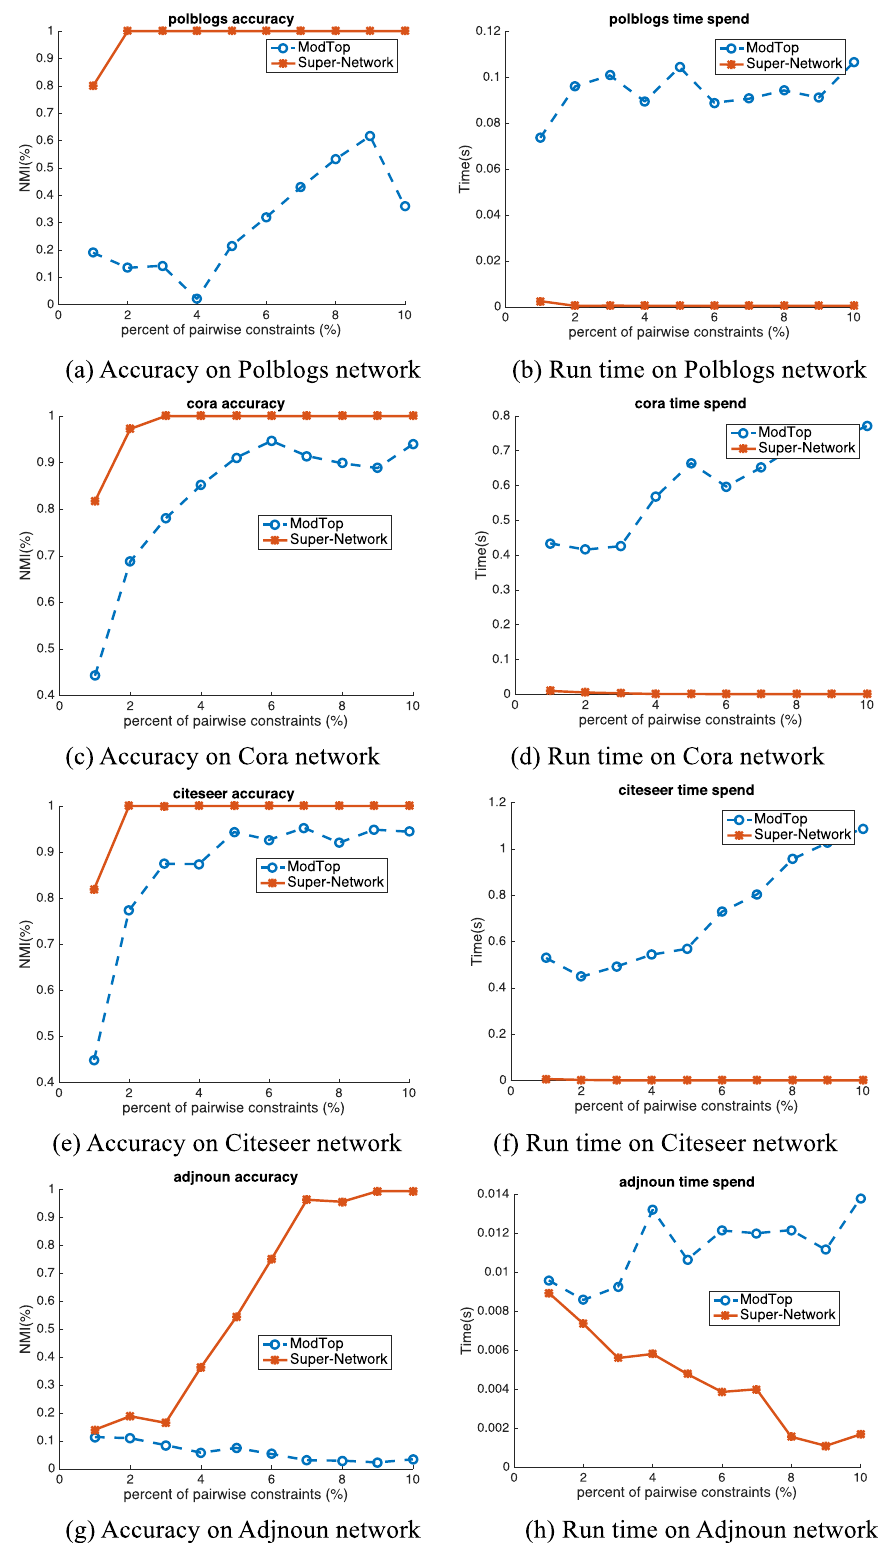
Figure 8. Accuracy (NMI) and run time (spent time in second) on four real world networks based on modularity maximization with spectral